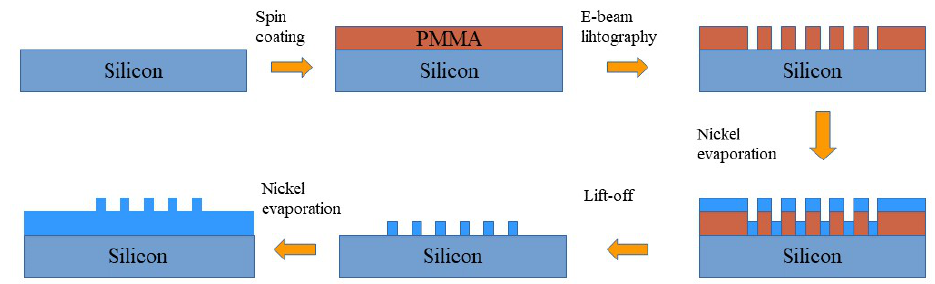
Figure 1. Schematic representation of the lift-off fabrication process. A pristine silicon wafer (100 n-type 1–10 Ω cm) was used as the mechanical substrate. The desired patterns were defined using a Polymethyl methacrylate (PMMA) mask and e-beam lithography (RAITH Quantum combined with a JEOL 7000 F FESEM at 30 KVolts) was used to define a set of periodic structures consisting of lines (50% crest/50% depression) with a specific periodicity on each site. To ensure pattern fidelity, a proximity corrected dose pattern was used. Following PMMA development, 100 nm Nickel was evaporated and lift-off was used to define the Nickel lines. After lift-off, a blanket evaporation of 200 nm Nickel was used to realise the final Nickel structure that is 200 nm Nickel with 100 nm thick Nickel protrusions. The pattern fidelity is ensured by the directionality of the Nickel evaporation. The period was varied by changing the deposition pattern rastered by